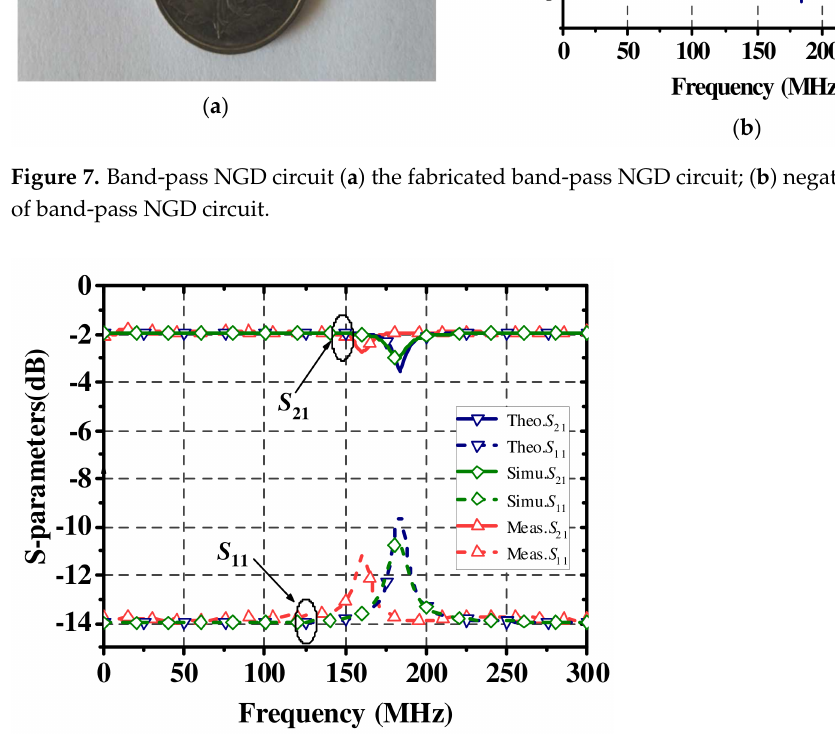
Figure 8. S 21 and S 11 of band-pass NGD circuit.